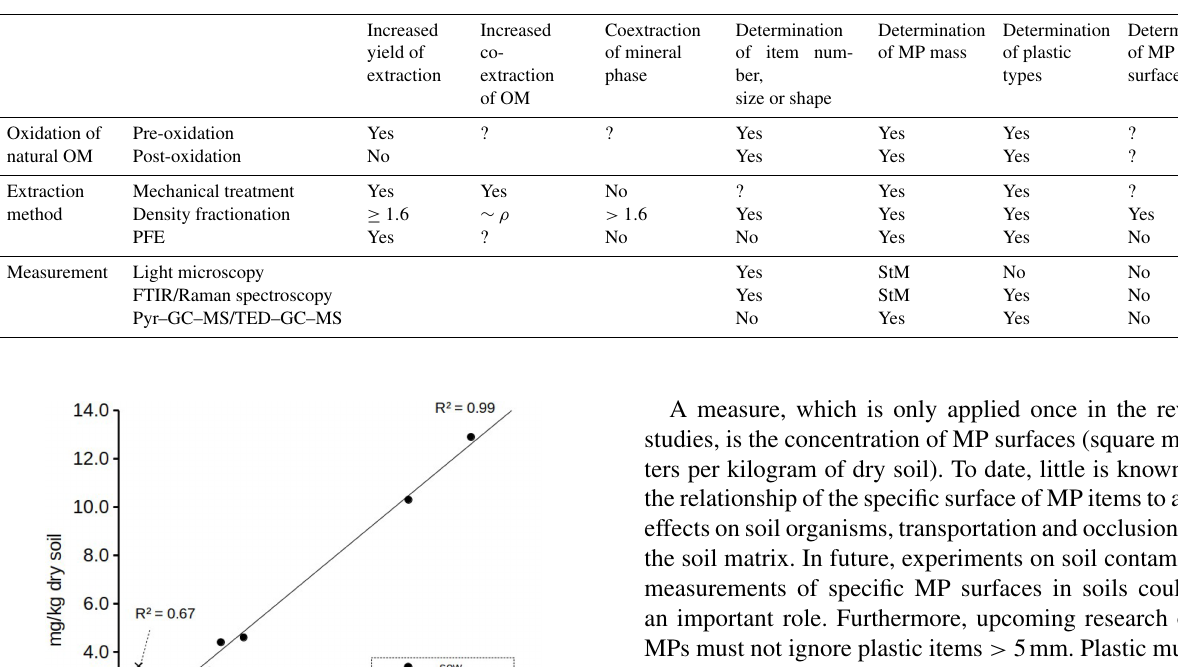
Table 2. Evaluation of procedural steps used for the extraction of microplastics from soil. Extraction methods, additional treatments and methods for measurement appear in various combinations. Their compatibility with given requirements is shown, based on the reviewed literature. Question marks indicate unknown performances, ρ refers to the density cut-off in grams per cubic centimeter, OM refers to organic matter, PFE refers to pressurized fluid extraction, FTIR refers to Fourier transform infrared spectroscopy, Pyr–GC–MS refers to pyrolysis–gas chromatography–mass spectrometry and TED–GC–MS refers to thermal extraction and desorption–gas chromatography–mass spectrometry. StM refers to shape-to-mass model.